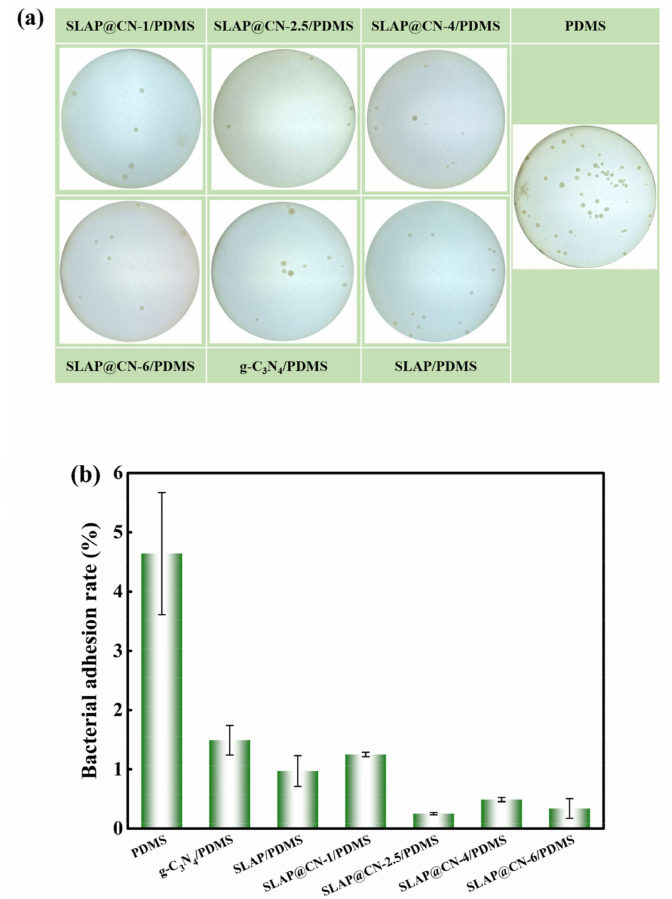
Figure 8. ( a ) Photograph of colony attachment of the coating; ( b ) bacterial attachment rate of the